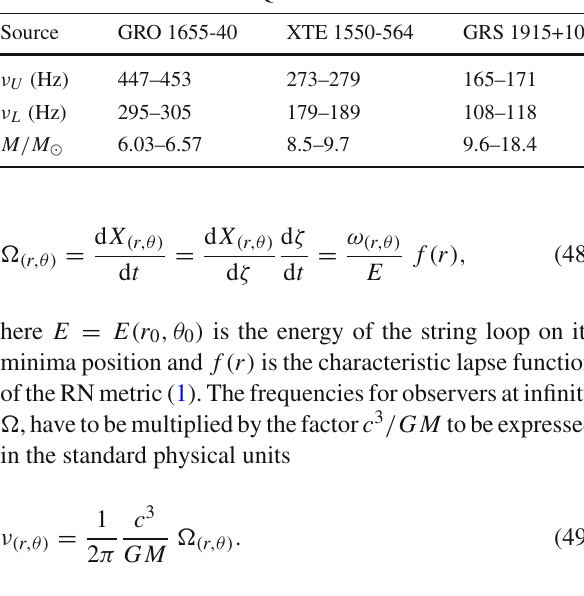
Fig. 8 ISEP for string loop and ISCO for charged particle with respect to black hole charge Q . ISEP for string are given for attracting ω = − 1, not interacting ω = 0 and repulsing ω = 1 interaction types between